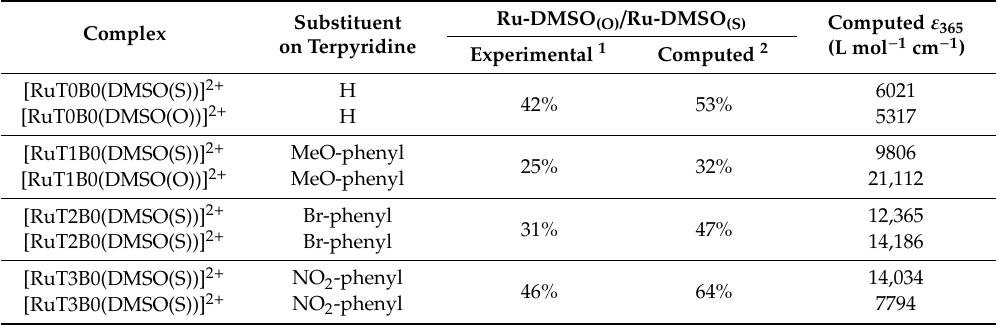
Table 5. Comparison of the Ru-DMSO (O) / Ru-DMSO (S) ratios determined by 1 H-NMR spectroscopy after one hour of irradiation of ruthenium complexes with various substituted terpyridine ligands at λ = 365 nm.